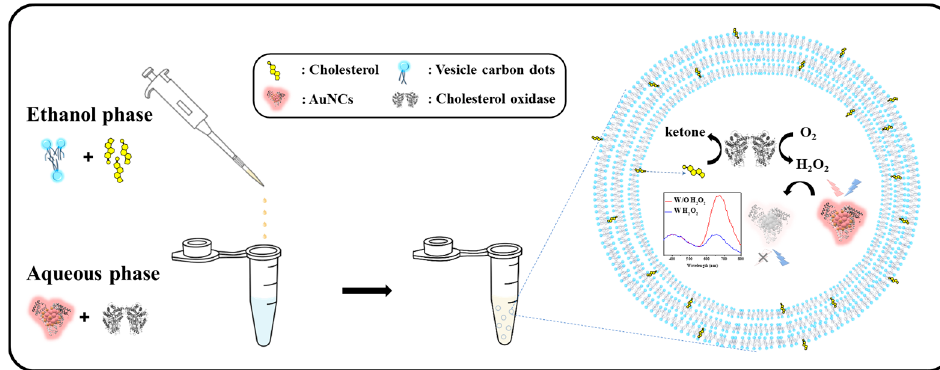
Scheme 1. Schematic drawing of a sensing system for detecting cholesterol.